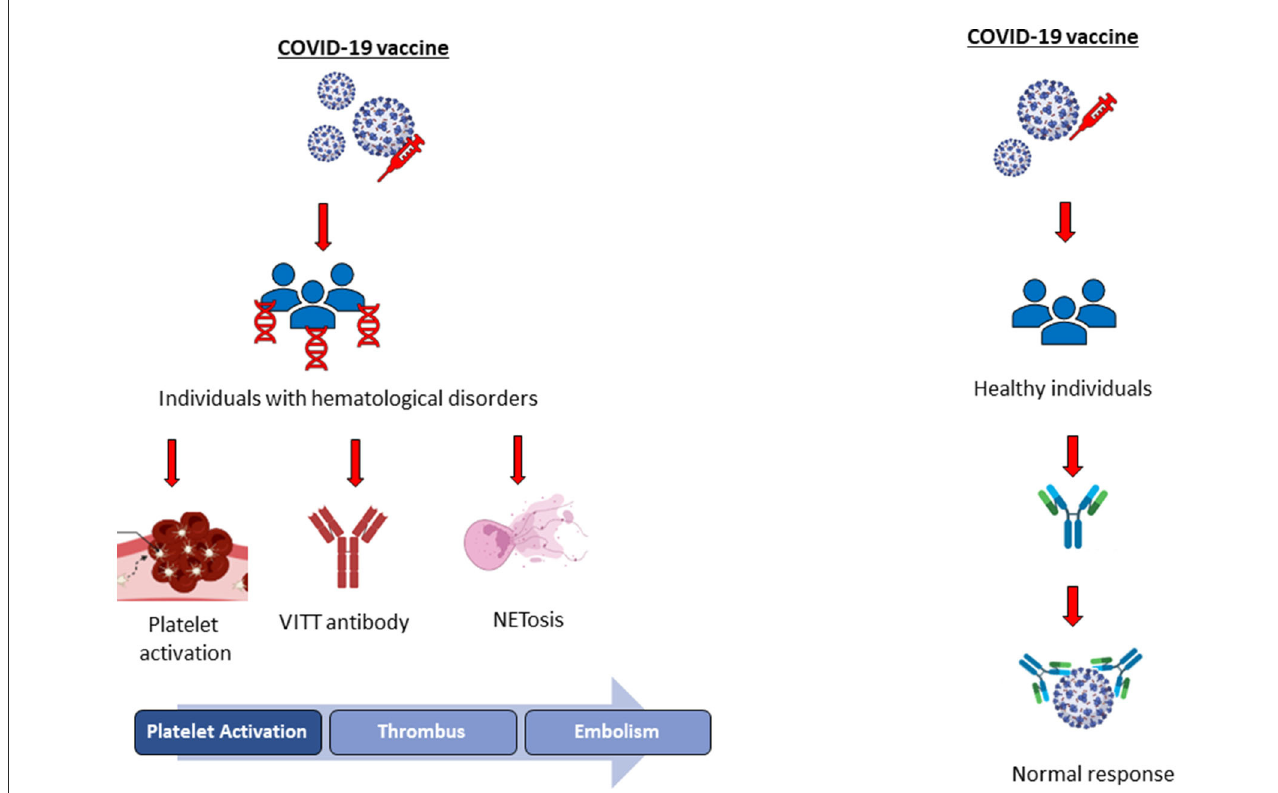
FIGURE1 Illustration of COVID-19 vaccine-induced adverse health effects in healthy individuals and people with hematological